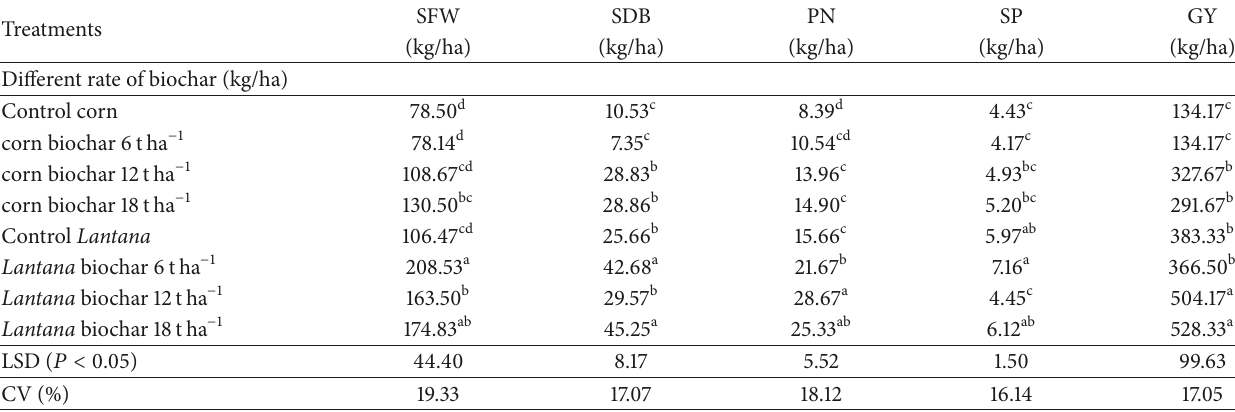
Table 5: Effect of different biochar on shoot fresh weight, shoot dry biomass, pod number, seed per pod, and grain yield of pea as influenced by different rate of biochar at